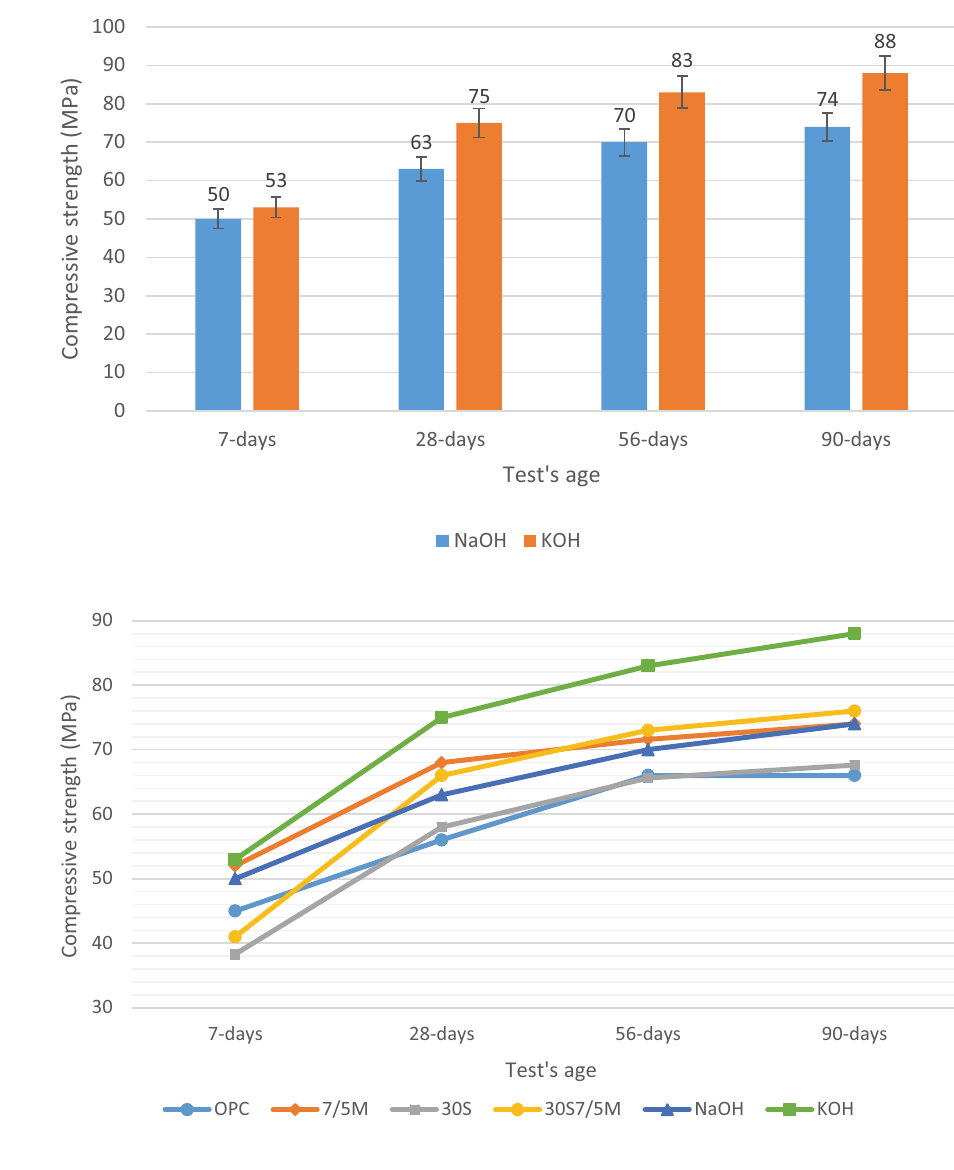
Fig. 8 The compressive strength of geopolymer-based mortars at various ages